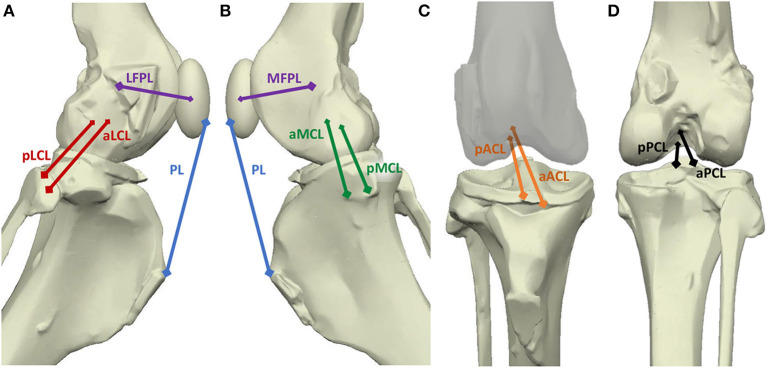
Different views of the stifle model with the schematic representation of the included ligaments. (A) Lateral view; (B) medial view; (C) frontal view without the patella; (D) Posterior view; PL in blue; MFPL and LFPL in violet; LCL anterior (aLCL) and posterior (pLCL) bundles in red; MCL anterior (aMCL) and posterior (pMCL) bundles in green; ACL anteromedial (aACL) and posterolateral (pACL) bundles in orange; PCL anterolateral (aPCL) and posteromedial (pPCL) bundles in black.